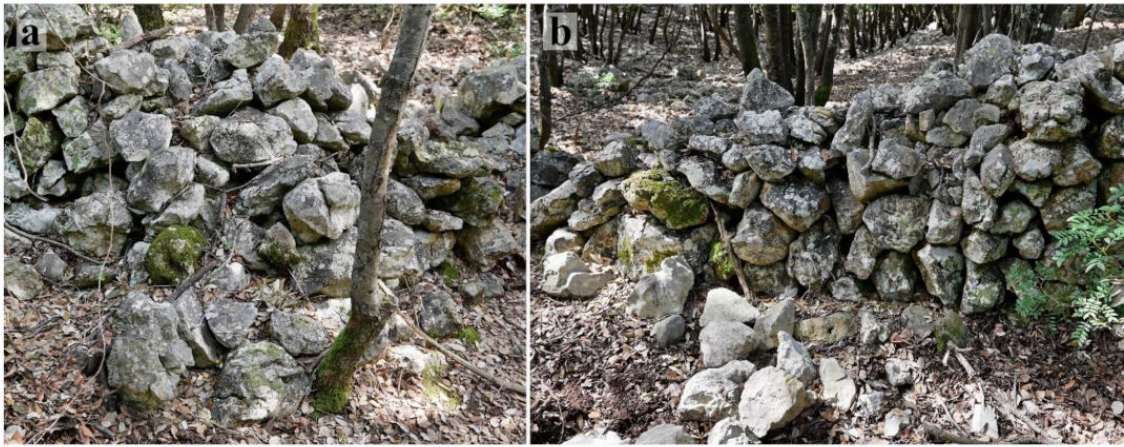
Figure 31. Wall joint on the enclosure wall at the intersection with the earlier wall in Figure 29a. ( a ) View looking north and ( b ) view looking south. (Photographs: M. Doneus 13 April 2022).